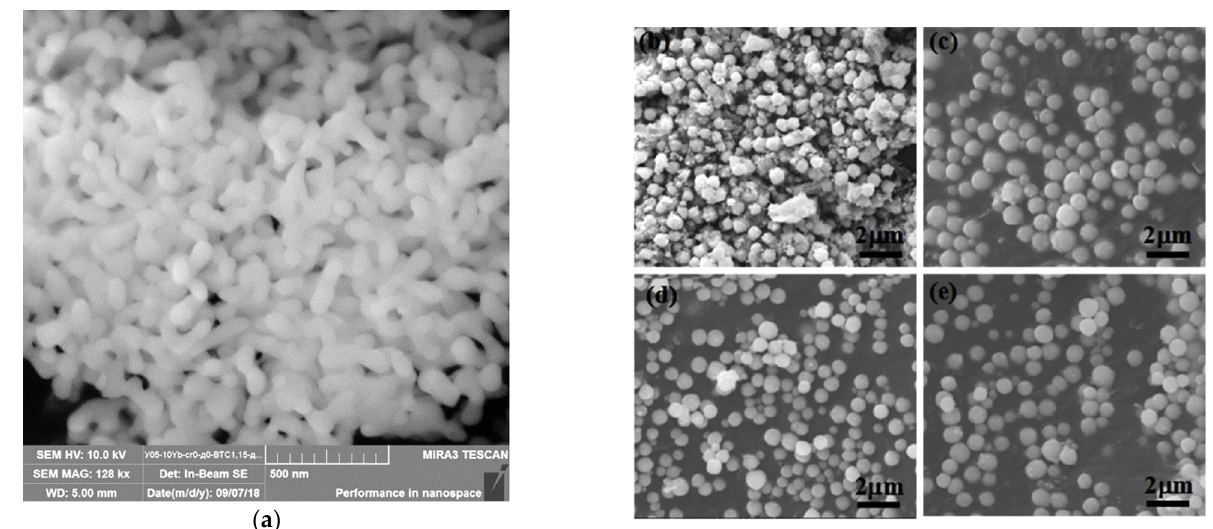
Figure 23. FESEM micrographs of the Yb:YAG ceramic nanopowder fabricated by chemical co-precipitation ( a ) (Reprinted with permission from [226]. Copyright 2019 Elsevier) and ( b–e ) SEM images of BCZT powders with different NaOH concentrations (Reprinted with permission from [228]. Copyright 2019 Elsevier).